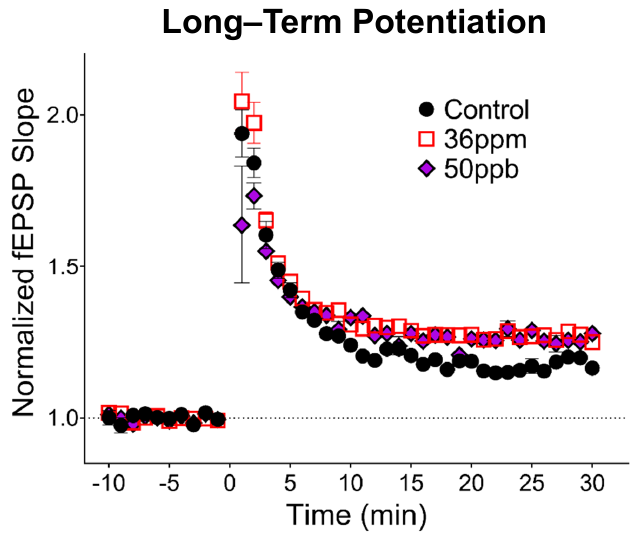
Figure 2. Effect of arsenic on hippocampal synaptic plasticity. Long-term potentiation induced by 1 × 100 Hz stimulation at time 0. Responses have been binned by one-minute intervals to aid visualization (average of four responses per minute).